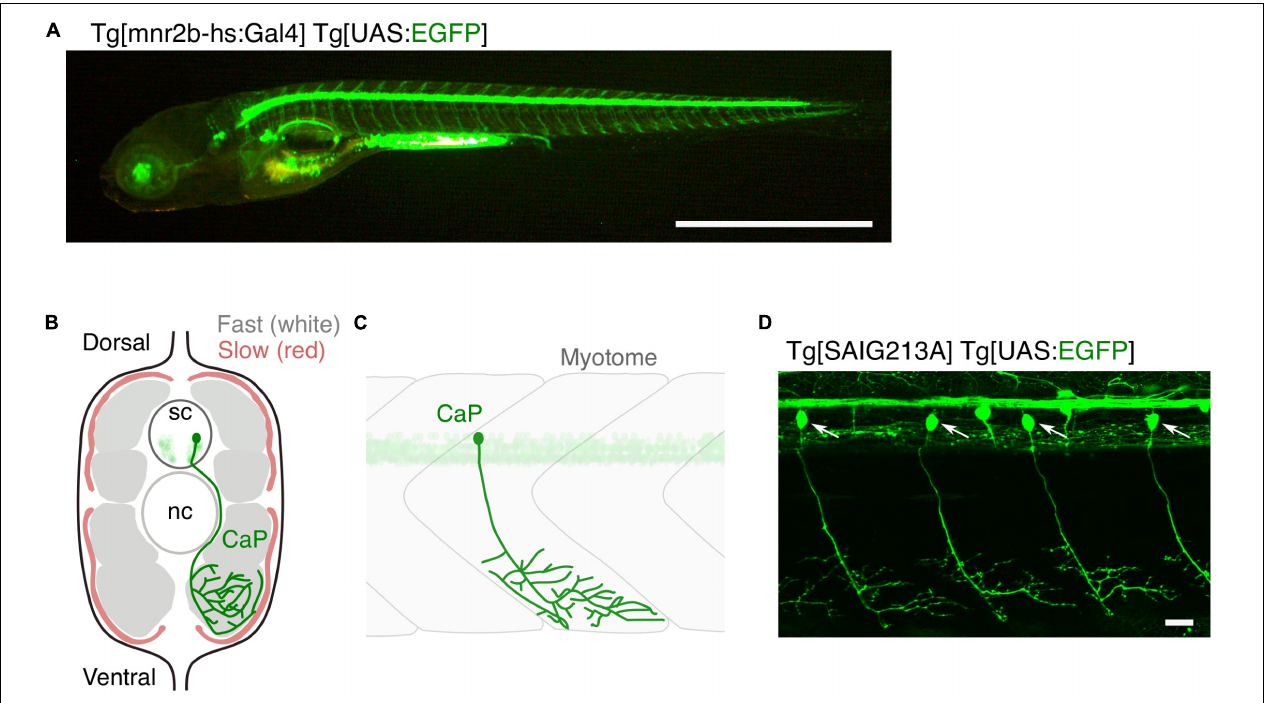
FIGURE 1 | Large and small populations of spinal motor neurons can be manipulated with the Gal4/UAS system in zebrafish. (A) Tg[mnr2b-hs:Gal4]; Tg[UAS:EGFP] larva at 5 day post-fertilization. In the Gal4 driver Tg[mnr2b-hs:Gal4], the Gal4FF transcription factor (Asakawa et al., 2008) is expressed from the bacterial artificial chromosome (BAC) transgene carrying the mnr2b locus (encoding the Mnx-type homeobox protein, which promotes motor neuron differentiation) and drives expression of a gene downstream of upstream activation sequence (UAS) in the most of the spinal motor neurons. (B) Schematic illustration of a transverse section of the middle trunk of a 5 day-old wild-type zebrafish larva, with the dorsal side up. Fast-twitch muscle and slow muscle are shown in gray and red, respectively. A CaP innervating the ventral myotome is shown in green. sc, spinal cord. nc, notochord. Illustration modified from Bello-Rojas et al. (2019). (C) Schematic illustration of a wild-type CaP innervating the ventral myotome, from lateral view. (D) Among the spinal motor neurons, CaPs (arrows) are selectively labeled in Tg[SAIG213A] Tg[UAS:EGFP] fish. Bars are 1 mm (A) and 20 µ m (D)